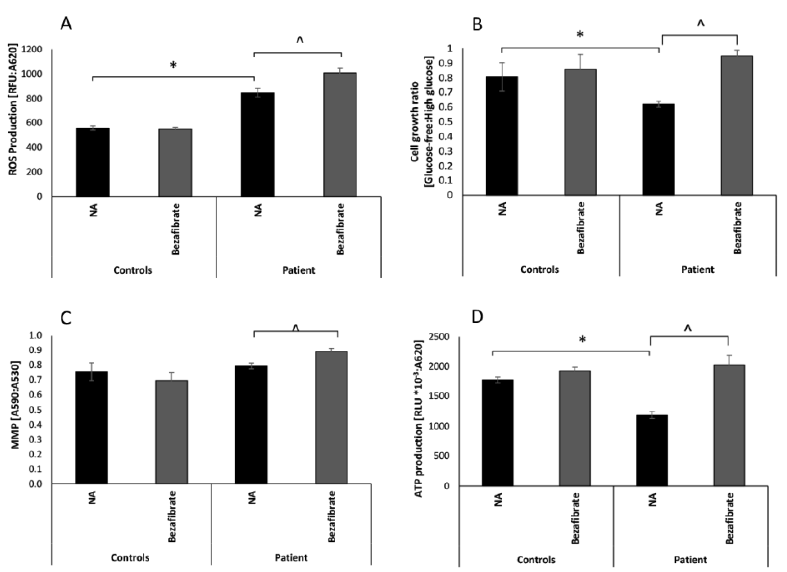
Figure 1. Patient and control fibroblasts’ growth, ATP production, mitochondrial membrane potential, and reactive oxygen species (ROS) production. Patient and control (n = 5) fibroblasts were seeded on 96-well plates and incubated for 72 h without additive (NA) or in the presence of 100 µ M bezafibrate. Intracellular ROS production ( A ) was measured using fluorometry with H 2 DCFDA. Cell growth ( B ) was measured by methylene blue (MB) and presented as the ratio between cell growth in glucose-free and growth in high-glucose. Mitochondrial membrane potential (MMP) ( C ) was measured using double staining with MitoTracker Green (MTG) and tetramethylrhodamine ethyl ester (TMRE). ATP production from glutamate and malate ( D ) was measured by luciferin-luciferase luminescence. Values are presented as normalized mean ± SEM; * p < 0.05 patient compared controls in the corresponding medium; ˆ p < 0.05 bezafibrate-treated compared to